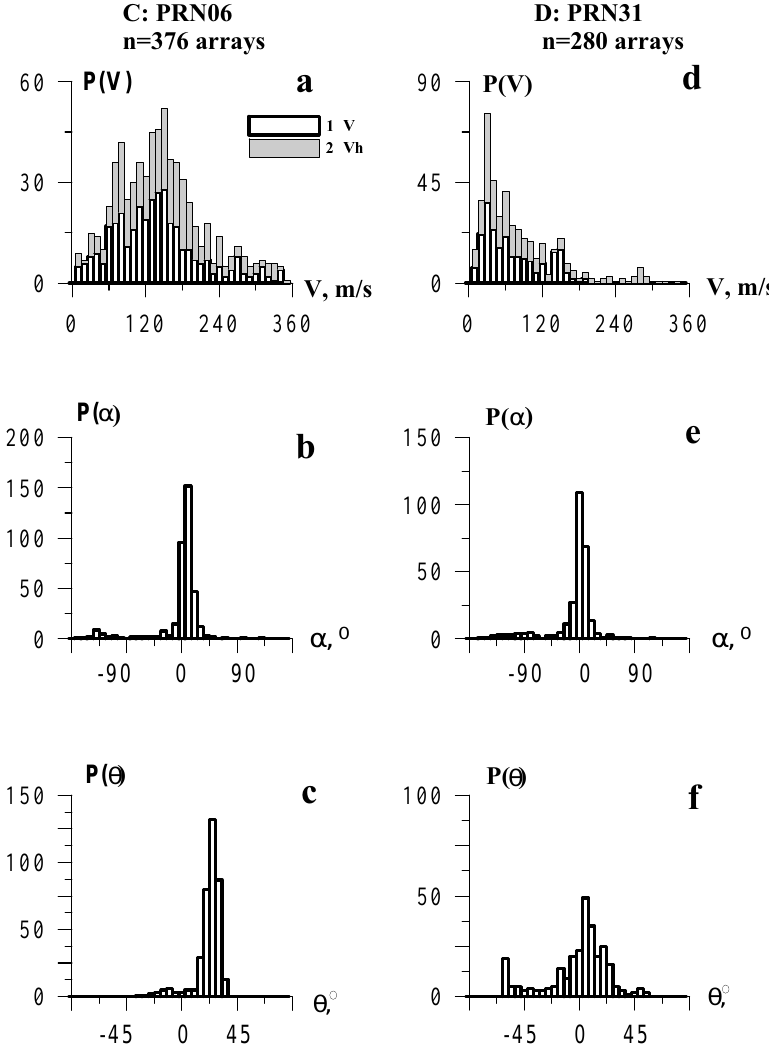
Fig. 10. Same as in Fig. 9, but for the “trace” C (on the left; 376 arrays), and for the “trace” D (on the right; 280